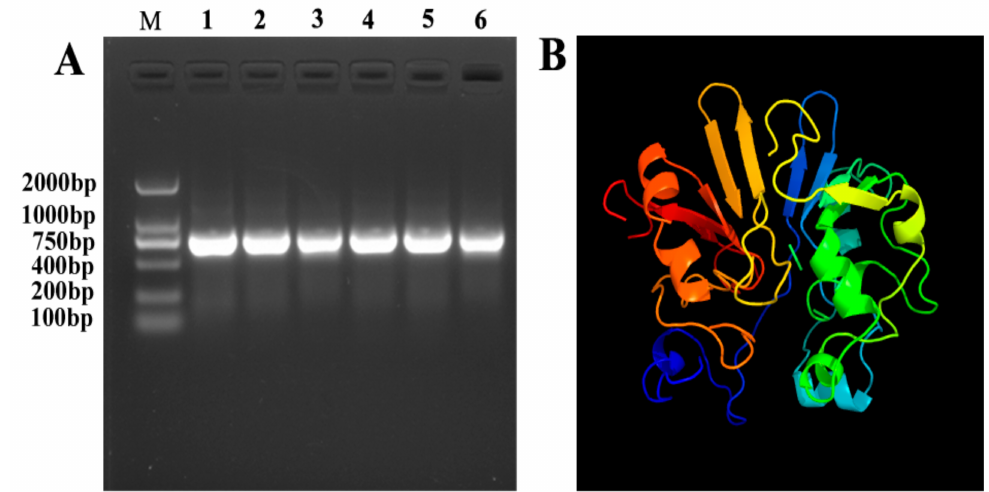
Figure 1. ( A ) PCR amplification of ytnP gene. Lane M: 2000 bp DNA Ladder (Invitrogen), Lane 1–6: ytnP gene (~770 bp). ( B ) The putative tertiary structure of YtnP modeled using the crystal structure of AHL lactonase from Bacillus (PDB accession number c3ehB) as the template. The coiled structure represents the alpha helix and the arrow represents the beta sheet. Table 1. The specific primers of virulence gene of A. hydrophila ATCC7966 and reference gene. Gene Primer Sequence Fragment Size